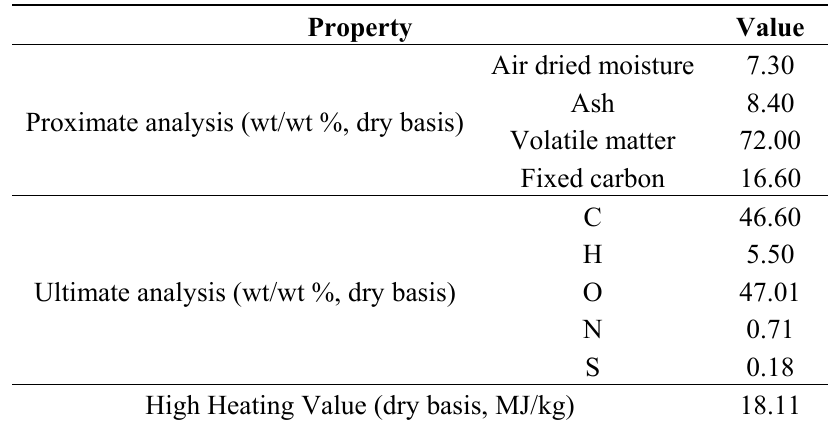
Table 1. Characteristics of the MGW.